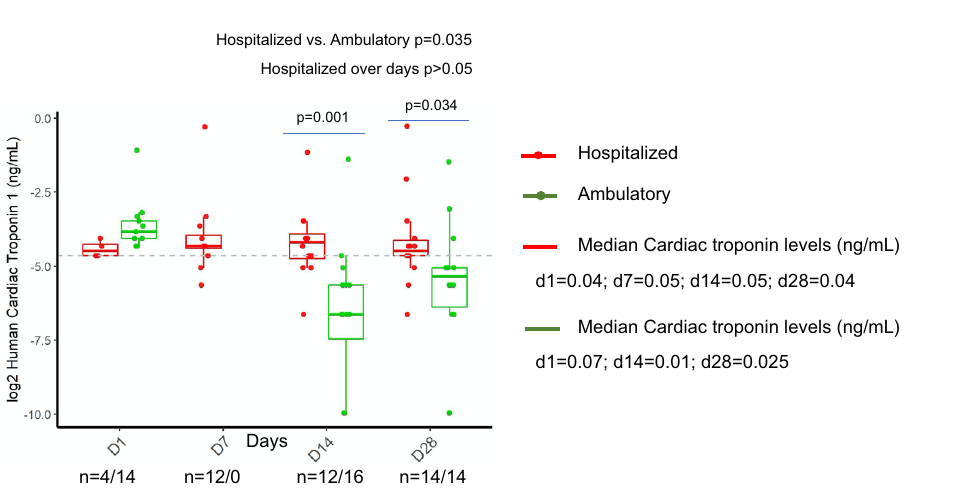
Figure 4. Longitudinal monitoring of Cardiac troponin I in hospitalized and ambulatory COVID-19 patients. Figure was created using ggplot2 package version 3.3.0. supported on R program software 38